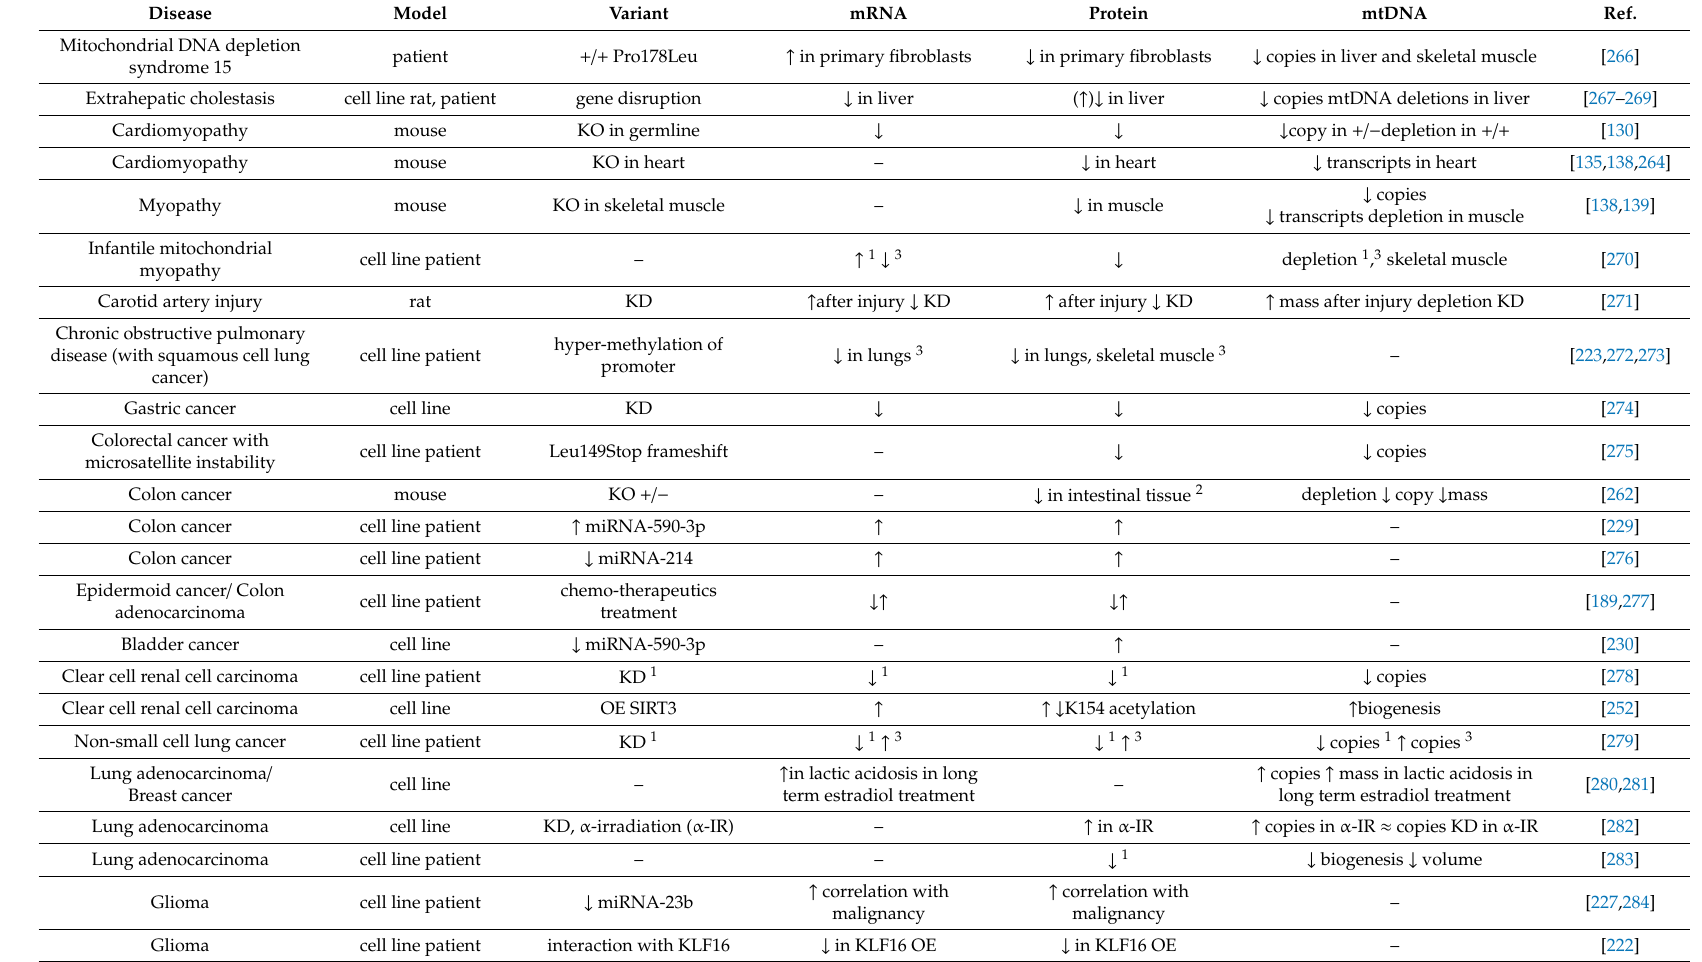
Table 1. Examples of human diseases whose pathologies involve